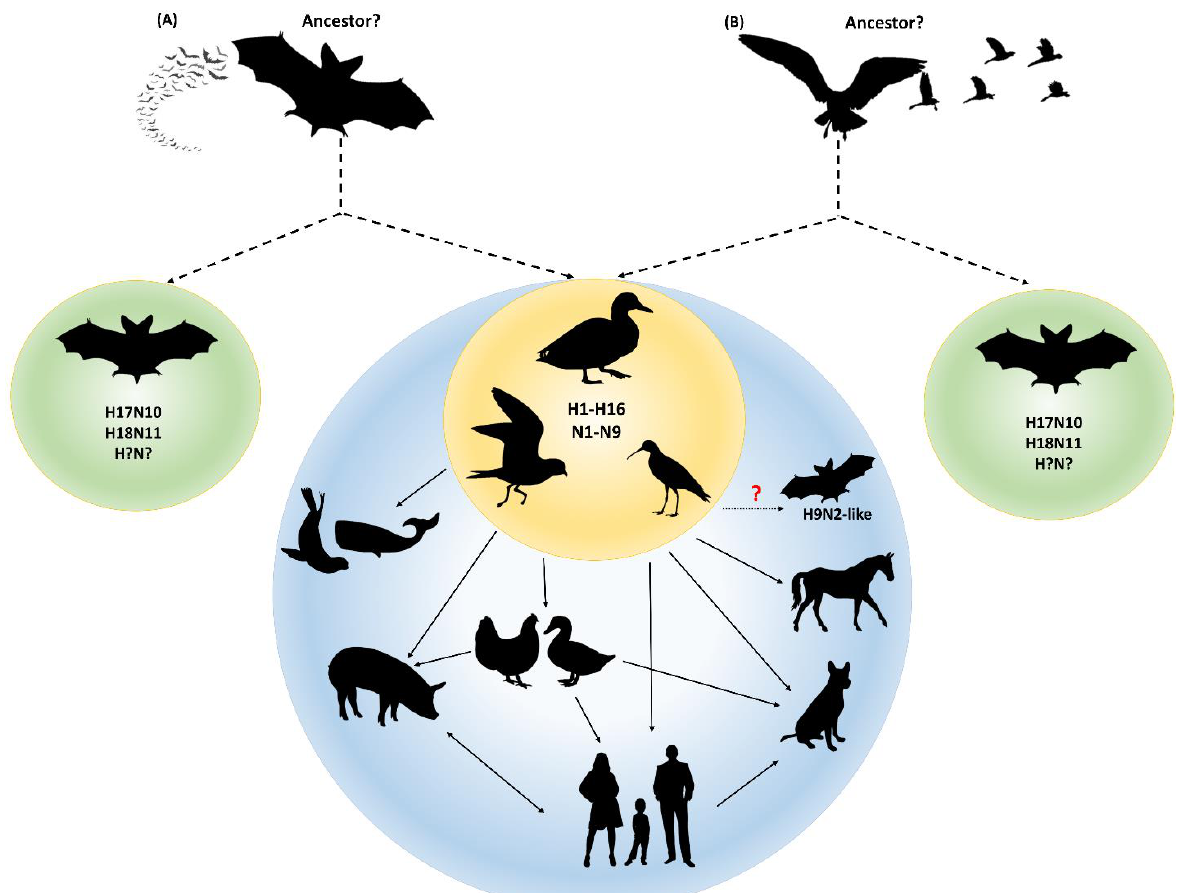
Figure 2. Two hypotheses on the origin of IAVs. ( A ) All IAVs originate from bats. Bats are considered to be the natural reservoirs of all IAVs that evolved for hundreds of years before transmission to birds in which rapid evolution occurred to form the classical IAVs. Some were circulating in bats to form distinct bat IAVs such as H17N10 and H18N11 (indicated by dashed arrow). ( B ) Avian species is the ancestor of all IAVs. IAVs originated from avian species in which the viruses were transmitted to wild waterfowl and bats to form classical IAVs and distinct bat IAVs (indicated by dashed arrow). Classical IAVs are circulating and evolving in waterfowl, from which they can be transmitted to a wide variety of other species. The H9N2-like bat virus is likely from the older classical IAVs that evolves very slowly in contrast to other conventional IAVs.